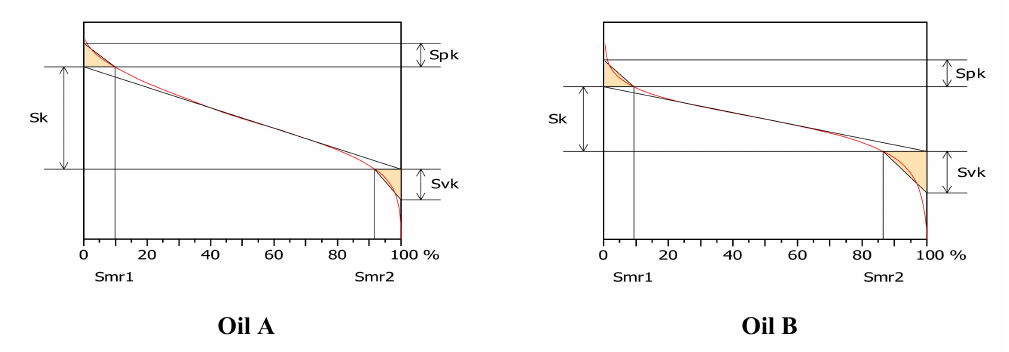
Figure 8. Abott–Firestone curve for a friction times of 36 h and high pass filter of 120 µ